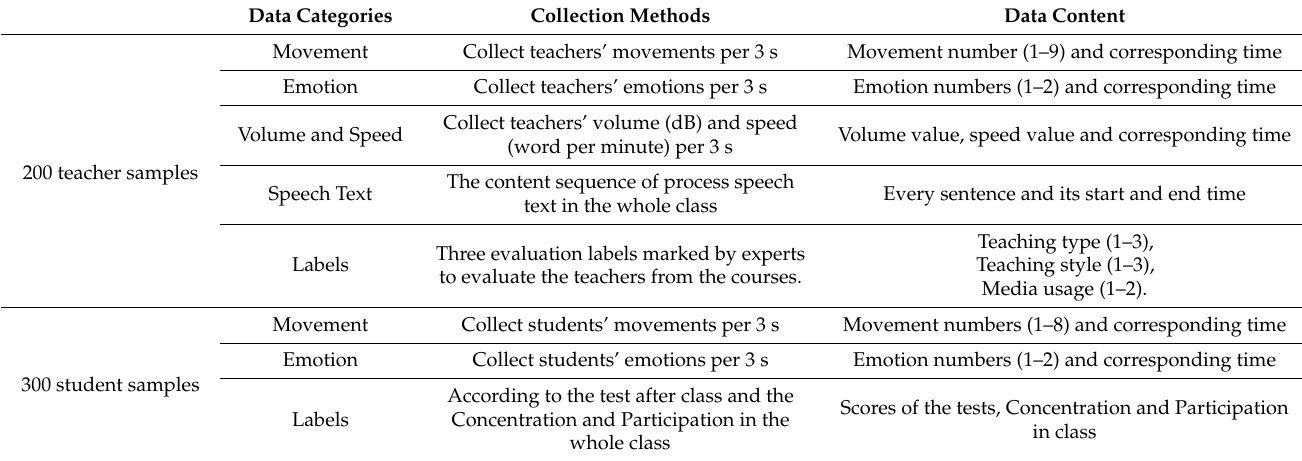
Table 3. The collection methods and content of the 8 data